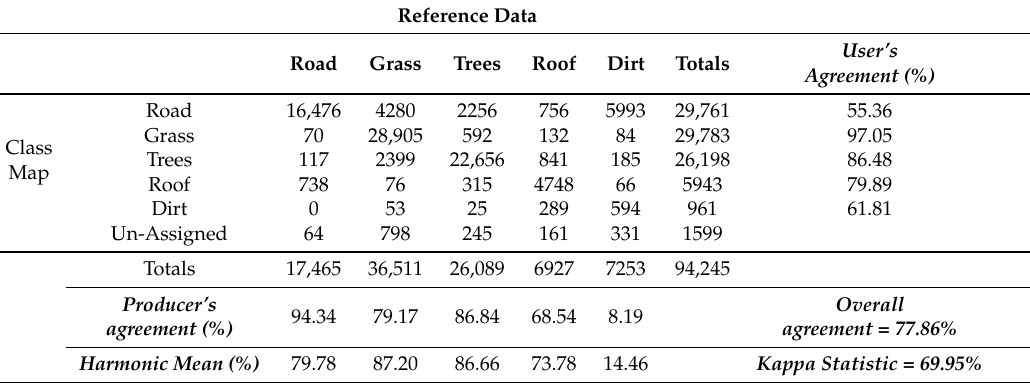
Table 6. Agreement matrix between SP Global and reference map.